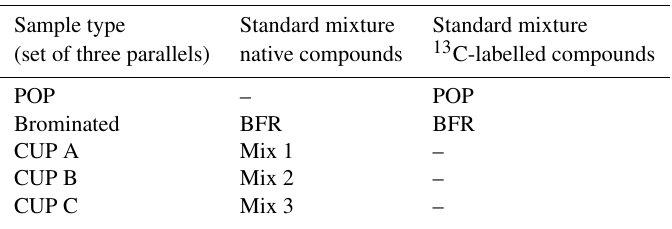
Table 1. Spiked standard mixtures for method evaluation